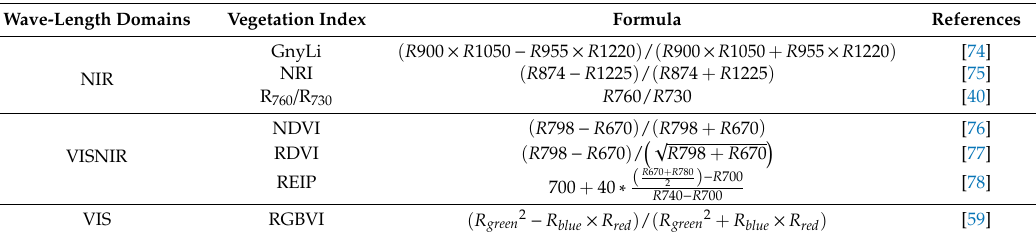
Table 1. Vegetation indices. Table modified from Tilly et al.